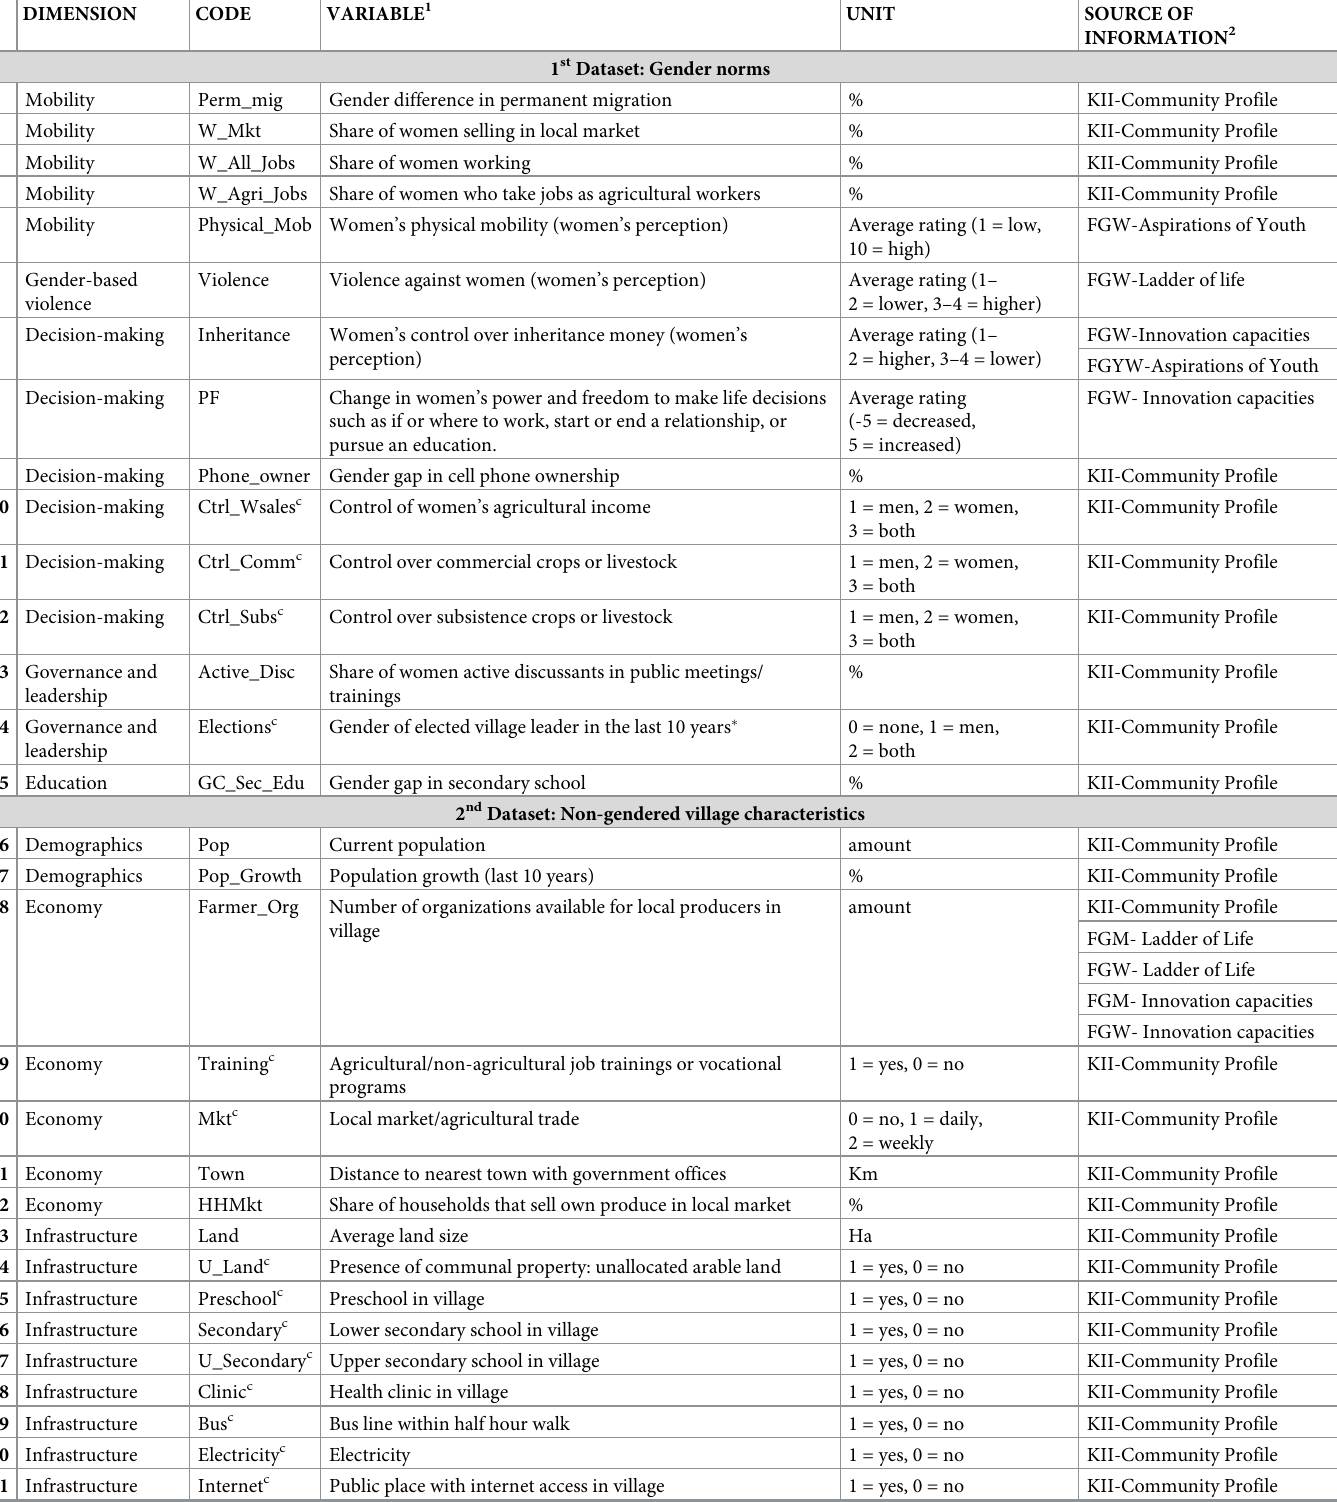
Table 2. Overview of